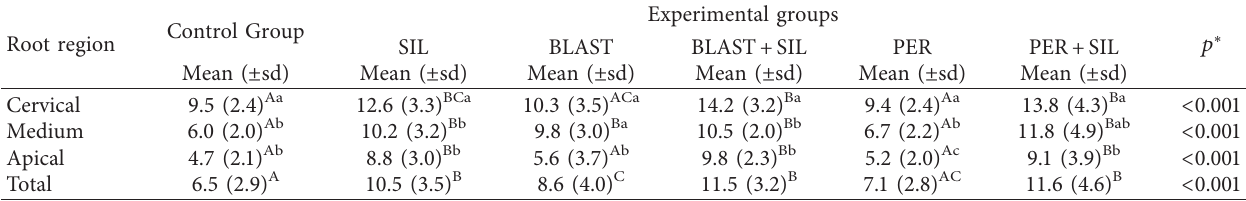
p was calculated using the ANOVA test followed by Tukey’s test. Different upper-case letters represent statistically significant differences ( p < 0.05) between treatment types in the same third root. Different lowercase letters represent statistically significant differences ( p < 0.05) between the third roots with the same treatment